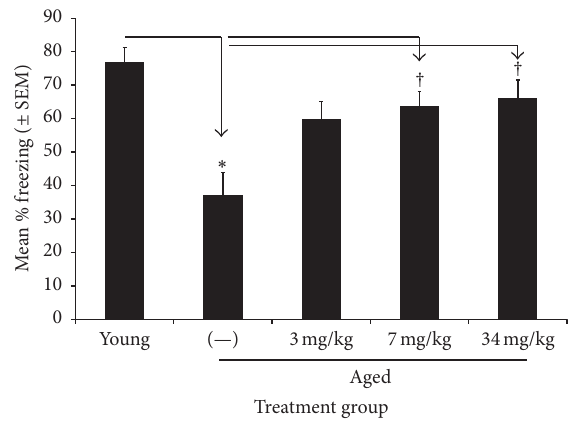
Figure3:EffectsofUP326onbehaviorandmemorywerealsotested using contextual fear conditioning (normal freezing behavior to an electrical shock). Contextual fear testing showed an improvement in normal freezing behavior in aged rats given UP326 approaching that of the young control rats. There was no effect of age or UP326 treatment to freezing to either the auditory cue or novel context. ∗ = 𝑝 < 0.0001 versus young controls; † 𝑝 < 0.0005 versus aged controls. 12 rats per group were used for each study.